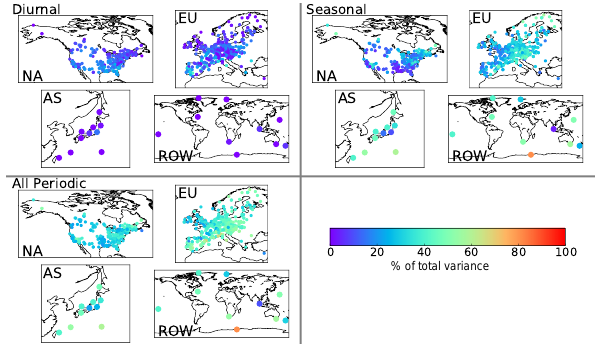
Figure 5. Observational fractional variance of time series by site from diurnal, seasonal and total periodicity. NA is North America, EU is Europe, AS is Asia, and ROW is rest of